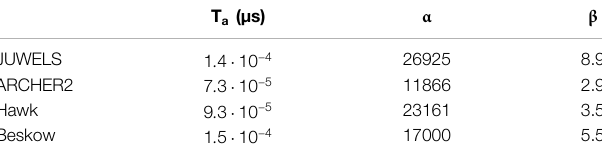
TABLE 4 | Overview of latencies and bandwidths on the systems used.